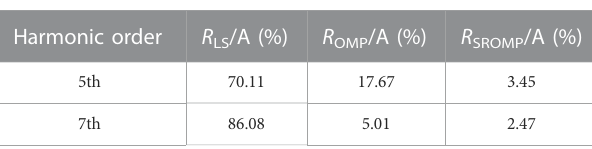
TABLE 6 Relative error.